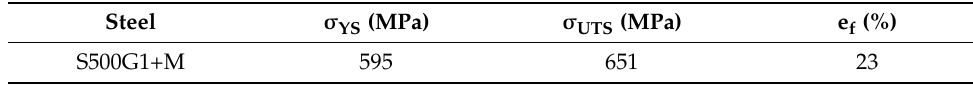
Table 2. Mechanical properties of the S500G1+M steel